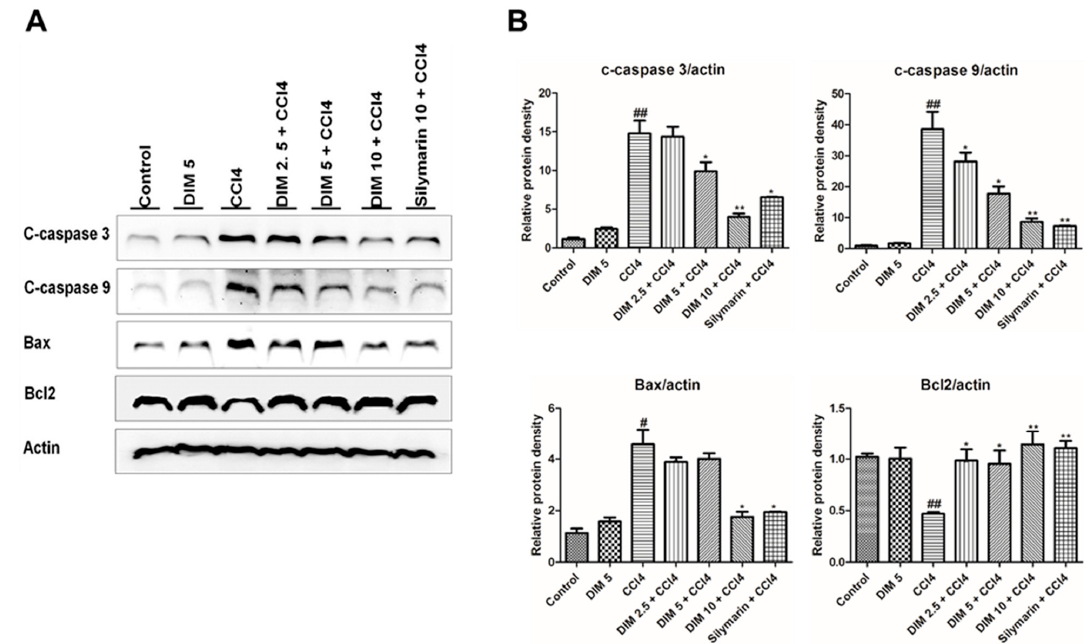
Figure 6. Pretreatment of DIM inhibits CCl 4 -induced hepatic cell death. ( A ) Western blot analysis showing the expression of apoptotic proteins (cleaved caspase-3, cleaved caspase-9); pro-apoptotic proteins Bax and anti-apoptotic protein Bcl2 at 24 h after CCl 4 injection. ( B ) Quantification of relative protein expression normalized to β -actin. The values represent the mean ± SD ( n = 3). # p < 0.05 and ## p < 0.01 denoted significant differences compared to the normal control group, * p < 0.05, ** p < 0.01, *** p < 0.001 compared to the CCl 4 group.